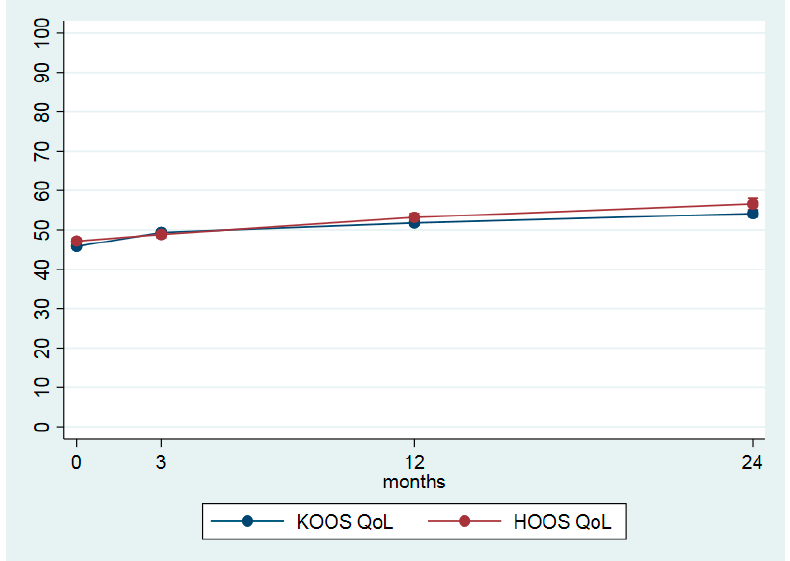
Figure 2. Joint related quality of life (QoL) (HOOS */KOOS **, scale 0 = worst–100 = best) at baseline, 3, 12 and 24 months given by estimated marginal means with 95% confidence intervals. * Knee injury and Osteoarthritis Outcome Score ** Hip disability and Osteoarthritis Outcome Score.